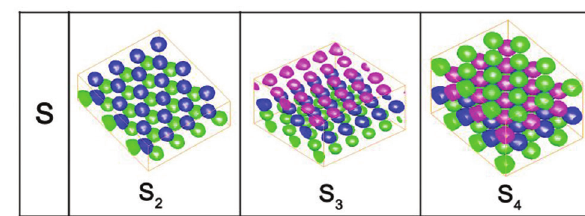
Figure 4: Spherical morphologies of block A ( f